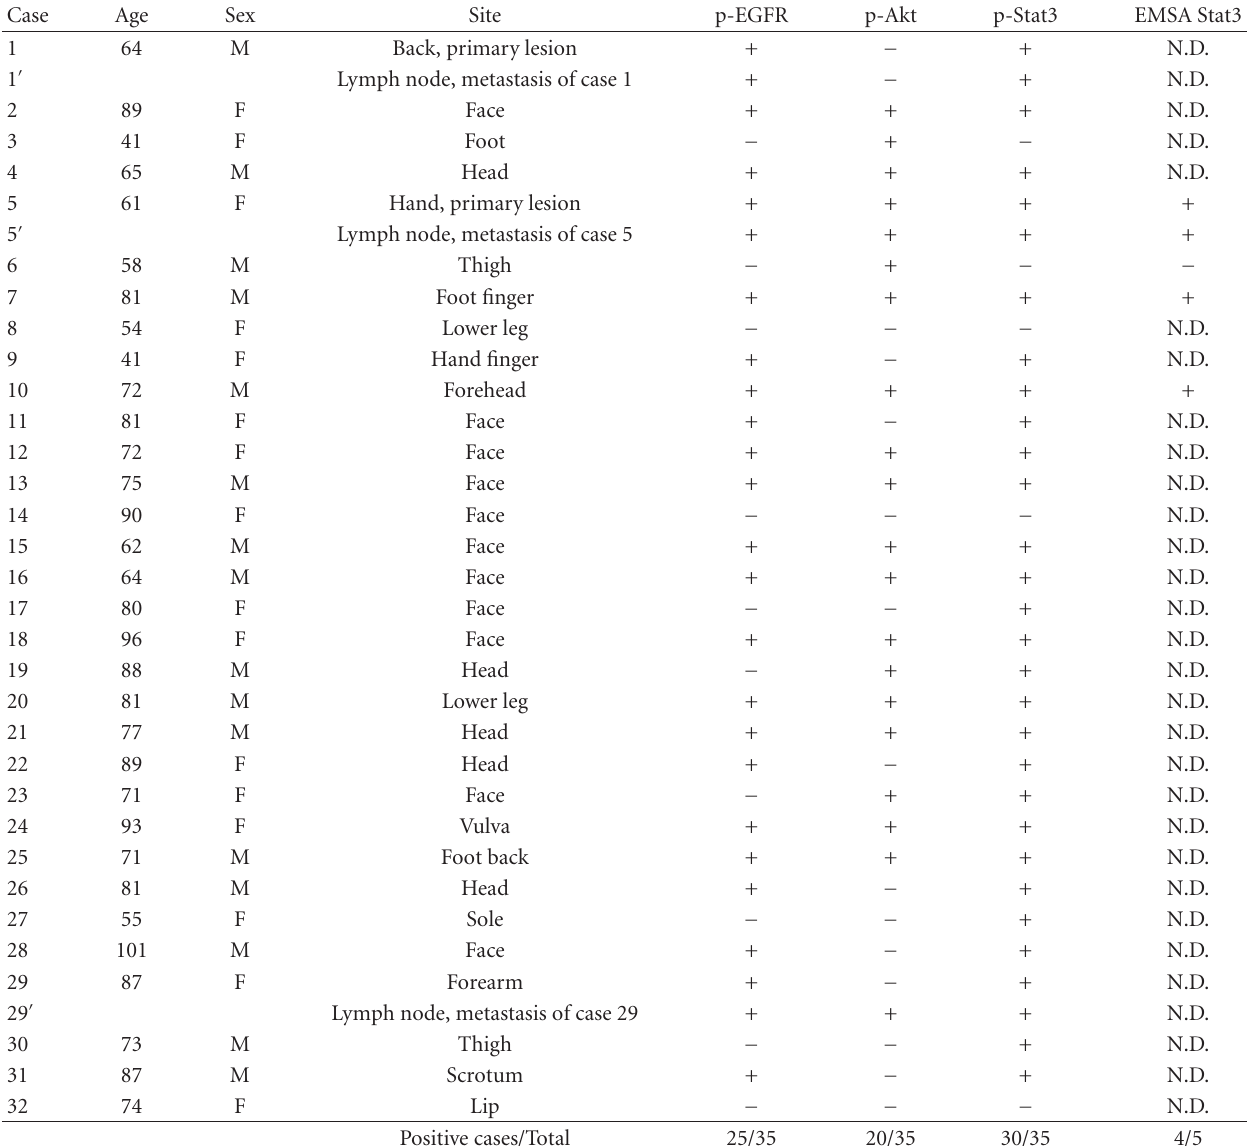
Table 1: Immunohistochemical analysis of human cutaneous SCC